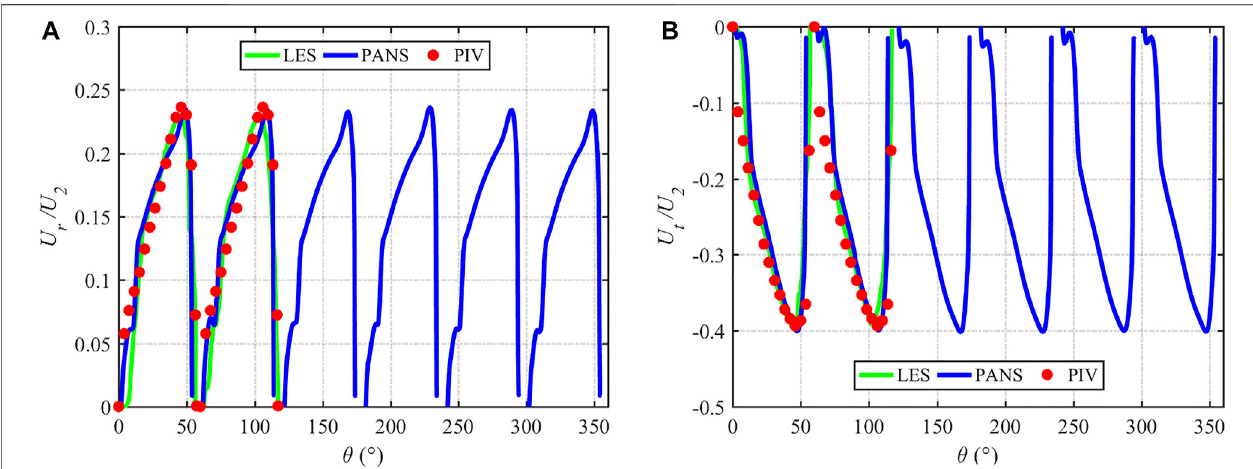
FIGURE 12 | Comparison of time-averaged velocity at Q = 1.0 Q 0 fl ow condition: (A) 0.5 R 2 radial velocity and (B) 0.5 R 2 tangential velocity.